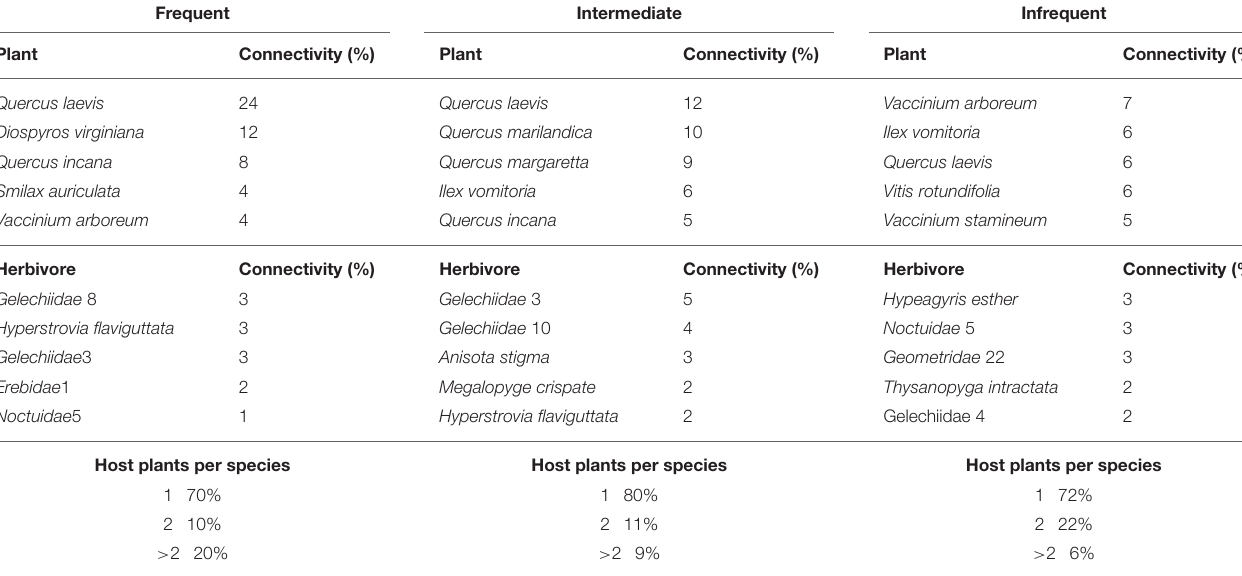
TABLE 1 | Relative connectivity of the most linked plant and herbivore species in each tri-trophic network within each fire return interval category. Frequent